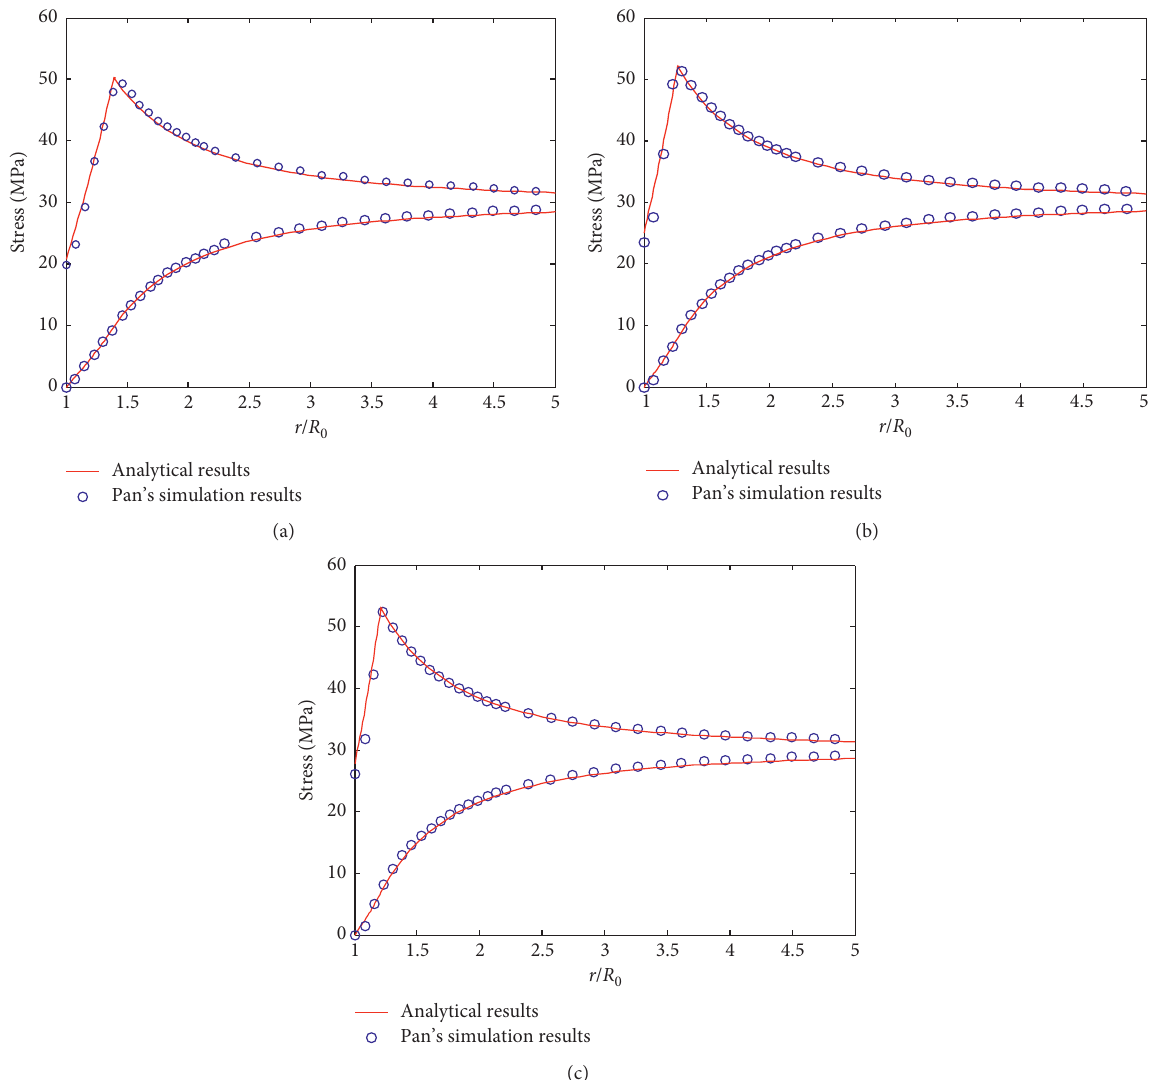
Figure 4: Comparison of stress distribution under (a) b � 0.0, (b) b � 0.5, and (c) b � 1.0. Table 2: The geometry and rock parameters used in this study. Geometry and rock parameters